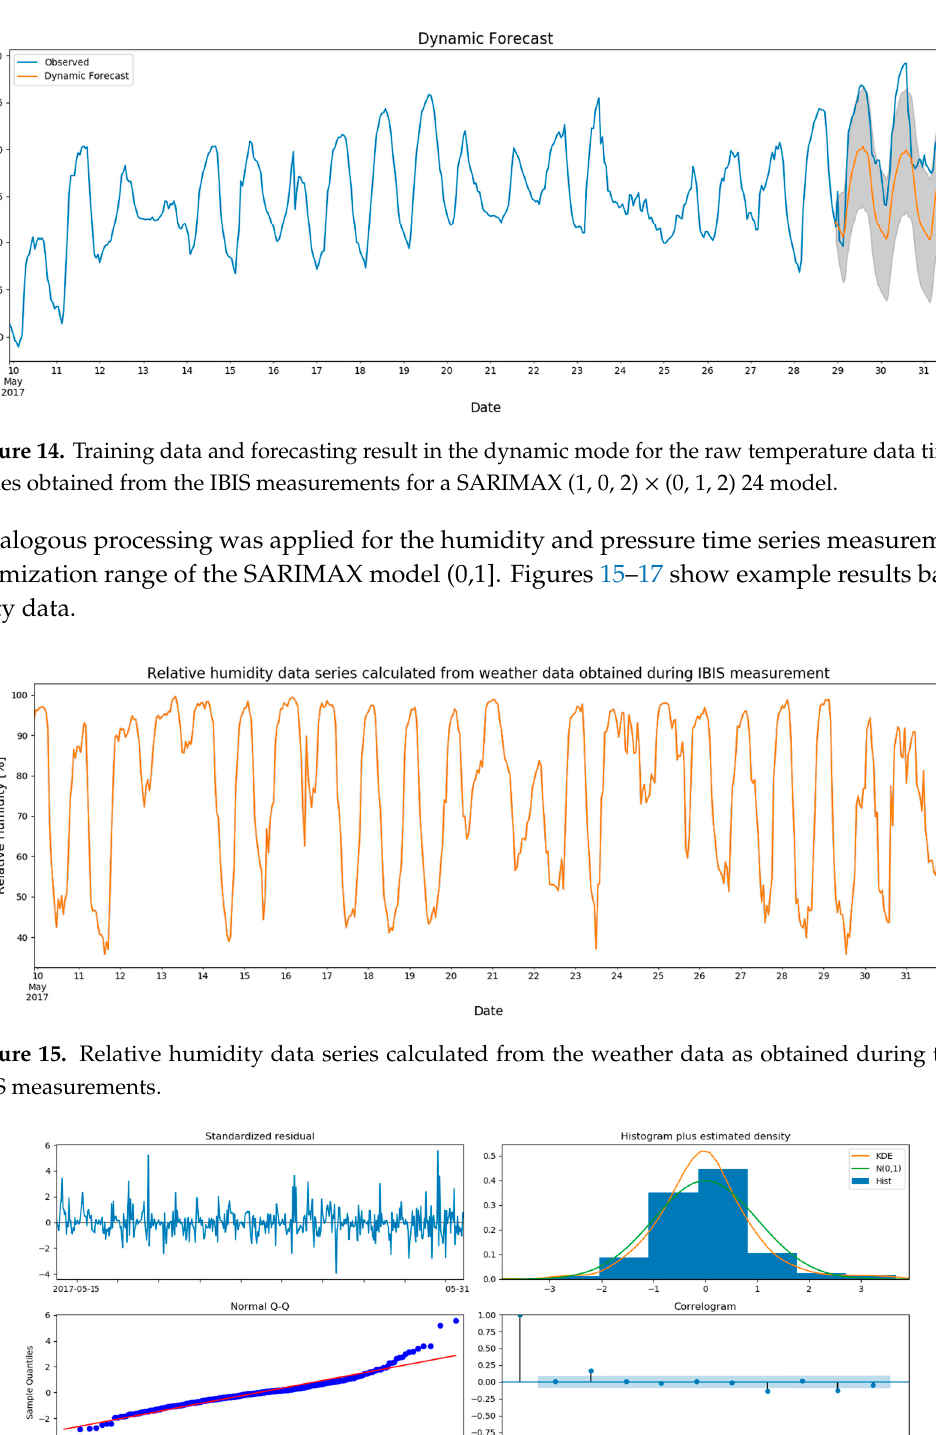
series obtained from the IBIS measurements with a SARIMAX (1, 0, 2) × (0, 1, 2) 24 model.